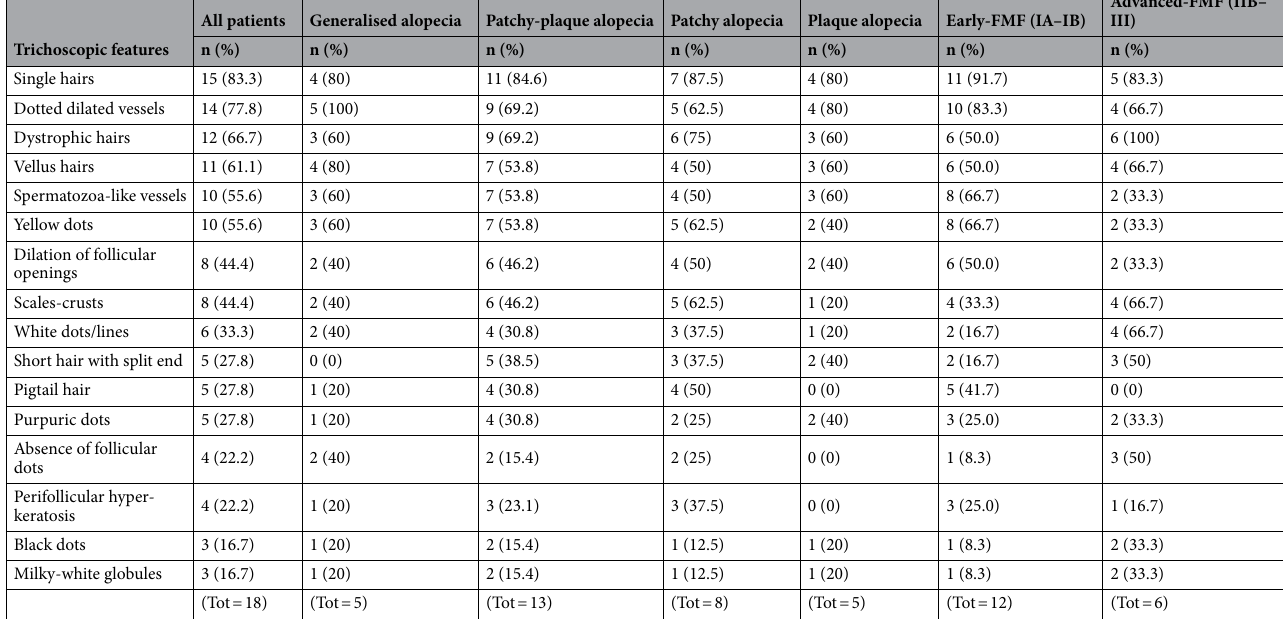
Table 3. Trichoscopic features of study population and correlations to clinical presentations and stage of